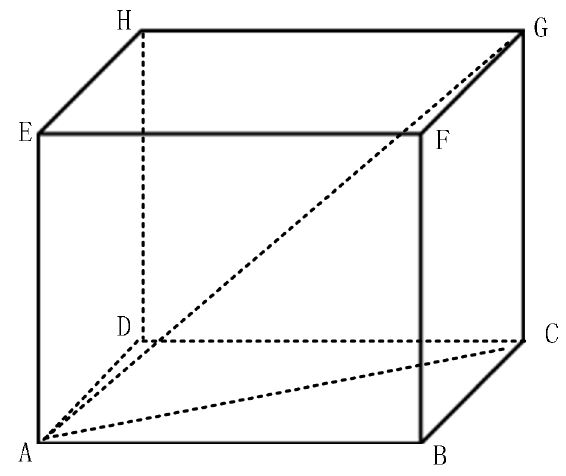
Figure 3. Deployment area of UWSNs with the side length of 100